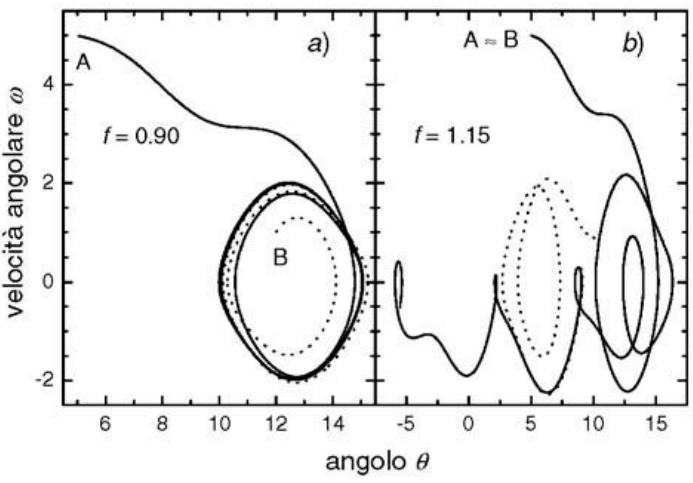
Figura 2 – Rappresentazione nel piano ( (cid:84) , (cid:90) ) dello spazio delle fasi di due traiettorie prodotte dal pendolo forzato; forza traente f = 0.90 (a) e f = 1.15 (b). A e B indicano i punti di